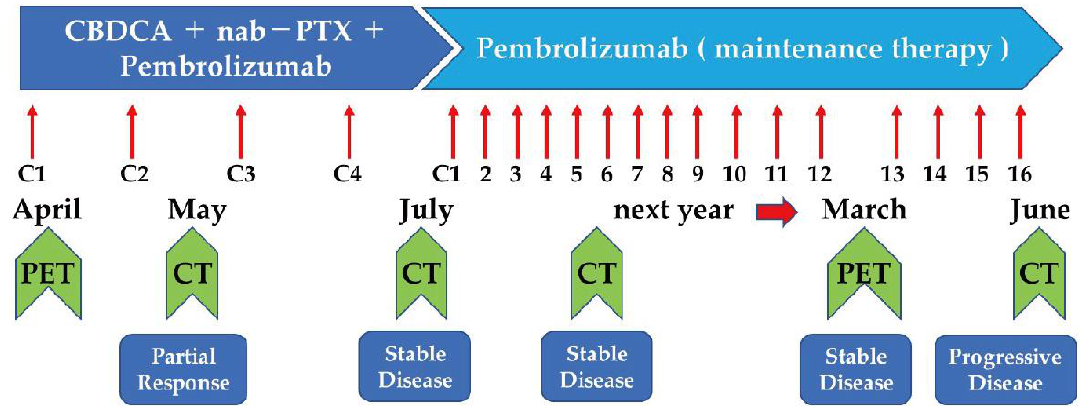
Figure 5. The clinical course of the patient. PET, positron emission tomography; CT, computed tomography; C, chemotherapy, CBDCA, carboplatin; PTX, paclitaxel; nab, nanoparticle albumin-bound.